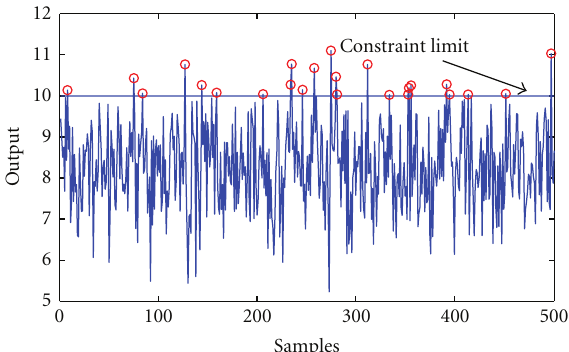
Figure 7: Improved case, optimal operation with probability con- straint level of 95%.